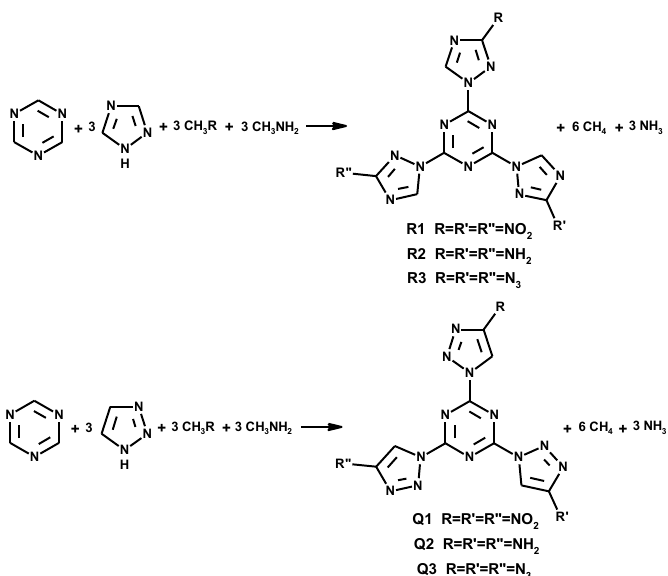
Figure 2. Isodesmic reaction schemes for s -triazine